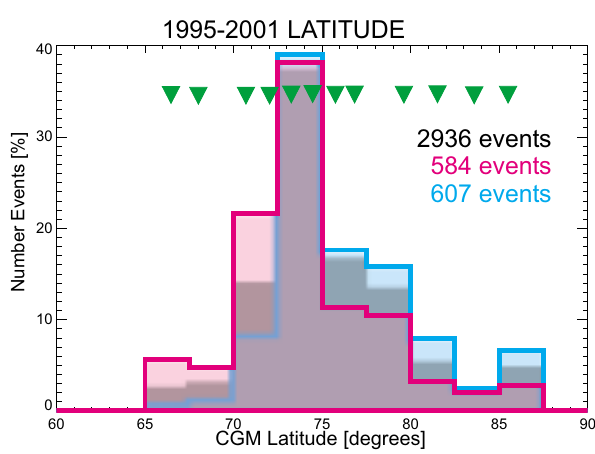
Fig. 12. The distribution of latitudes of events is displayed using bins of 2.5 degrees. The gray block-diagram presents the full set of events, the magenta line and shading the large amplitude subgroup, and the cyan line and shading the small amplitude subgroup. Green triangles mark the location of the Greenland west coast